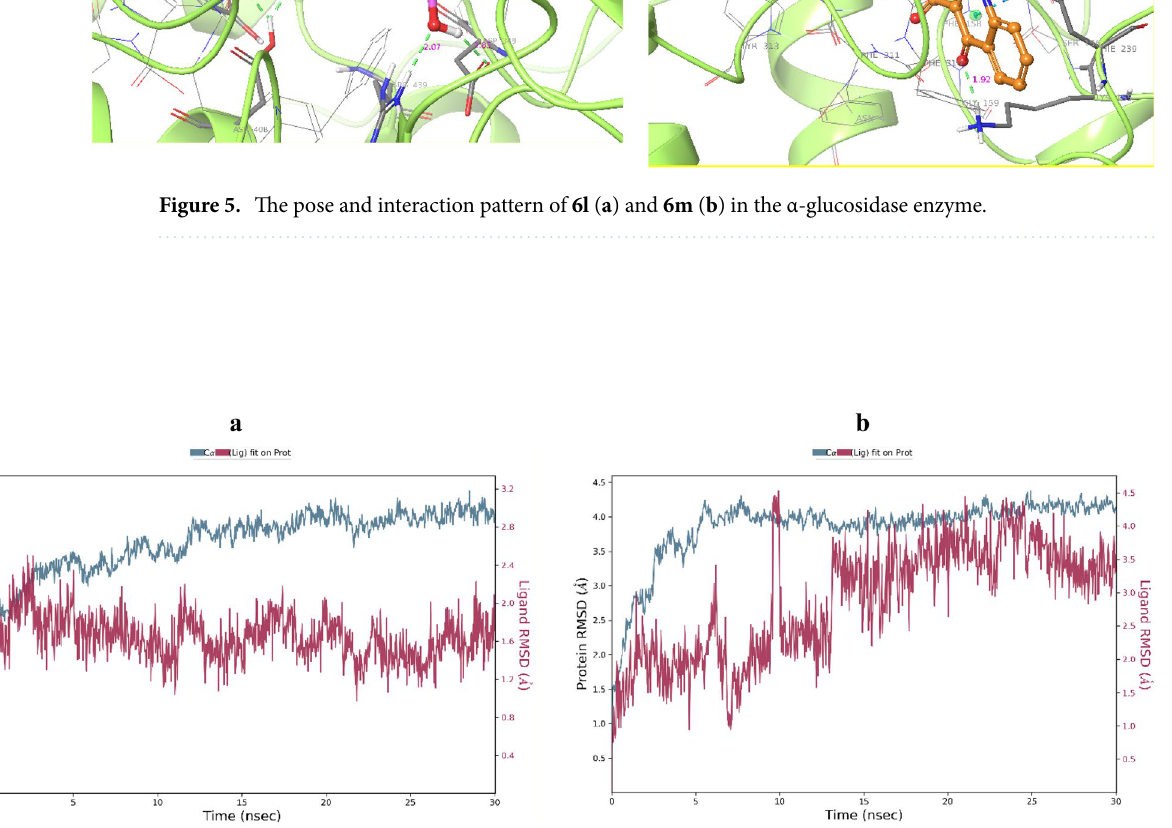
Figure 6. RMSD plot of the α-glucosidase backbone in complexed with 6l ( a ) and 6m ( b